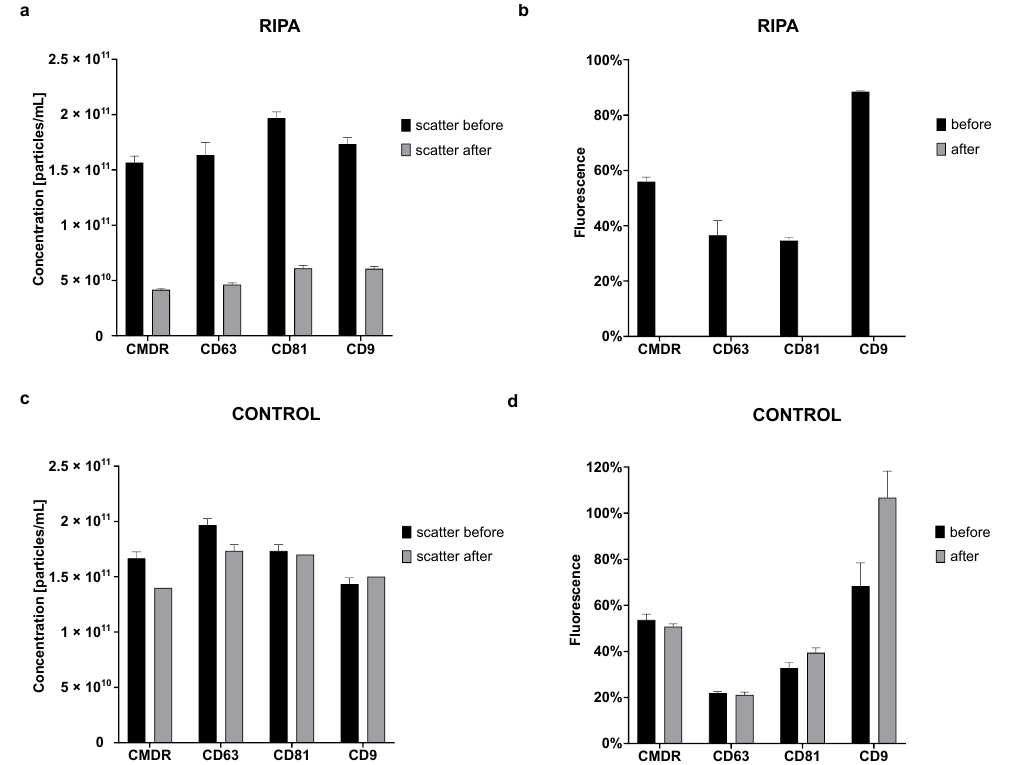
Figure 7. RIPA lysis of standard EVs derived from the NSCLC cell line. ( a ) The concentration of particles measured in scatter mode after labeling with CMDR and fluorescent antibodies against tetraspanin markers before and after incubation with RIPA lysis buffer. ( b ) The percent of fluorescent particles in comparison to all particles visible in scatter mode before and after incubation with RIPA lysis buffer. ( c ) The concentration of particles measured in scatter mode after labeling before and after incubation with PBS (control). ( d ) The percent of fluorescent particles in comparison to all particles visible in scatter mode before and after incubation with PBS as the control). Graphs ( a – d ) present the mean and SD from three